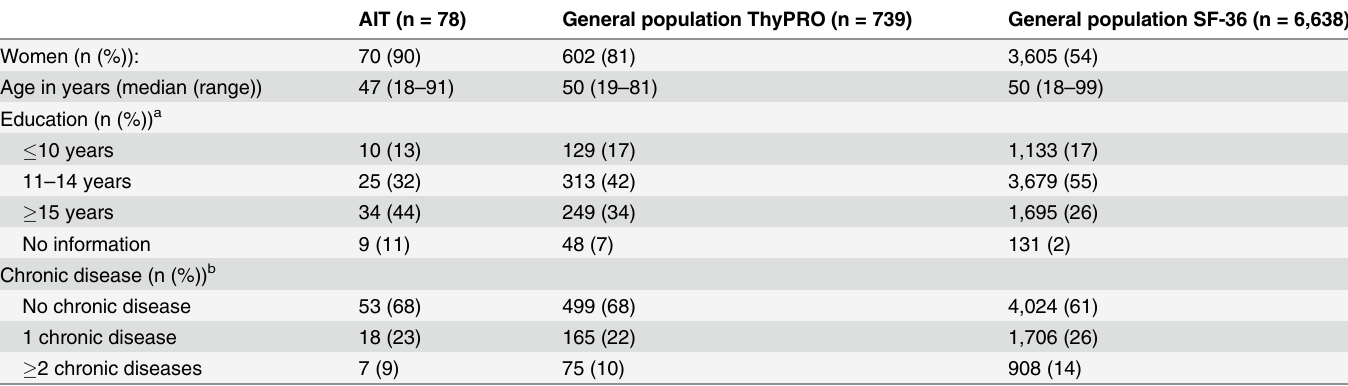
Table 1. Baseline sociodemographic characteristics of patients with autoimmune thyroiditis (AIT) and general population samples.